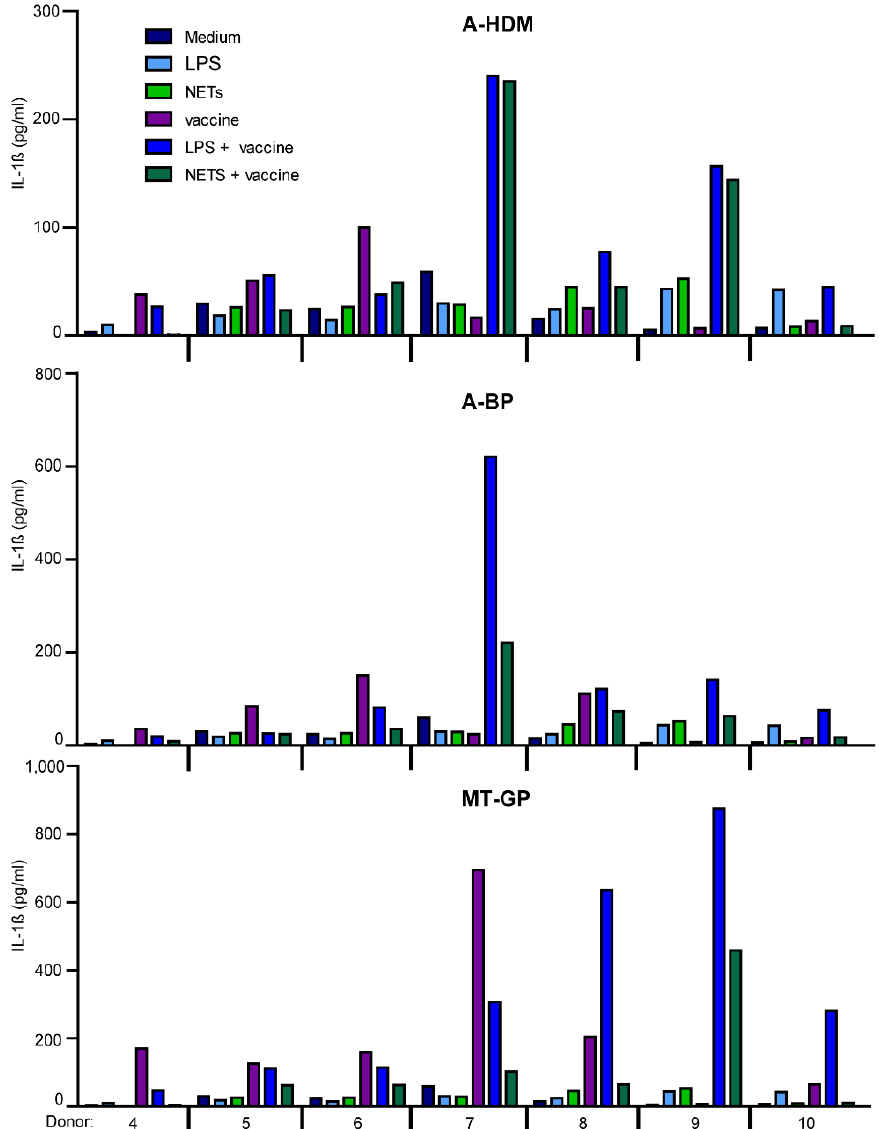
Figure 7. Induction of IL-1 β in PBMC by LPS- or NET-priming and stimulation with complete vaccines. PBMC were incubated for 3 h with either medium (neg. control), ultrapure LPS (25 pg/mL) or isolated NETs (100 ng/mL) and then stimulated for 6 h with either one of the al- um-adjuvanted vaccines (A-HDM, A-BP) or the MPLA-adjuvanted one MT-GP. Cytokine levels of IL-1 β in SN were measured by ELISA. Cumulative data of 4 independent experiments with 7 dif- ferent donors are shown. Subjects No. 4 and No. 7 were